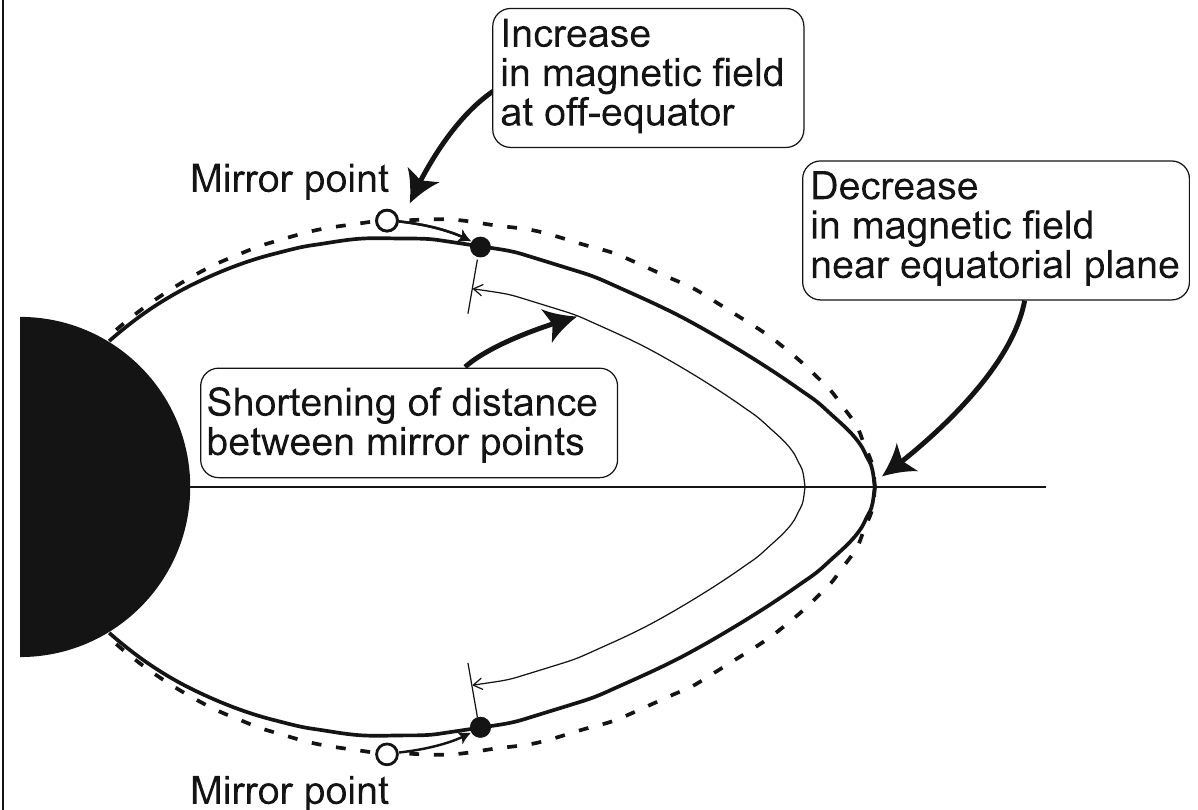
Fig. 8 Adiabatic deceleration (near the equatorial plane) and acceleration (at off-equator) of ions in the storm-time magnetic field. The dashed line indicates the magnetic field line in the pre-storm time, and the solid line indicates the magnetic field line deformed by the storm-time ring